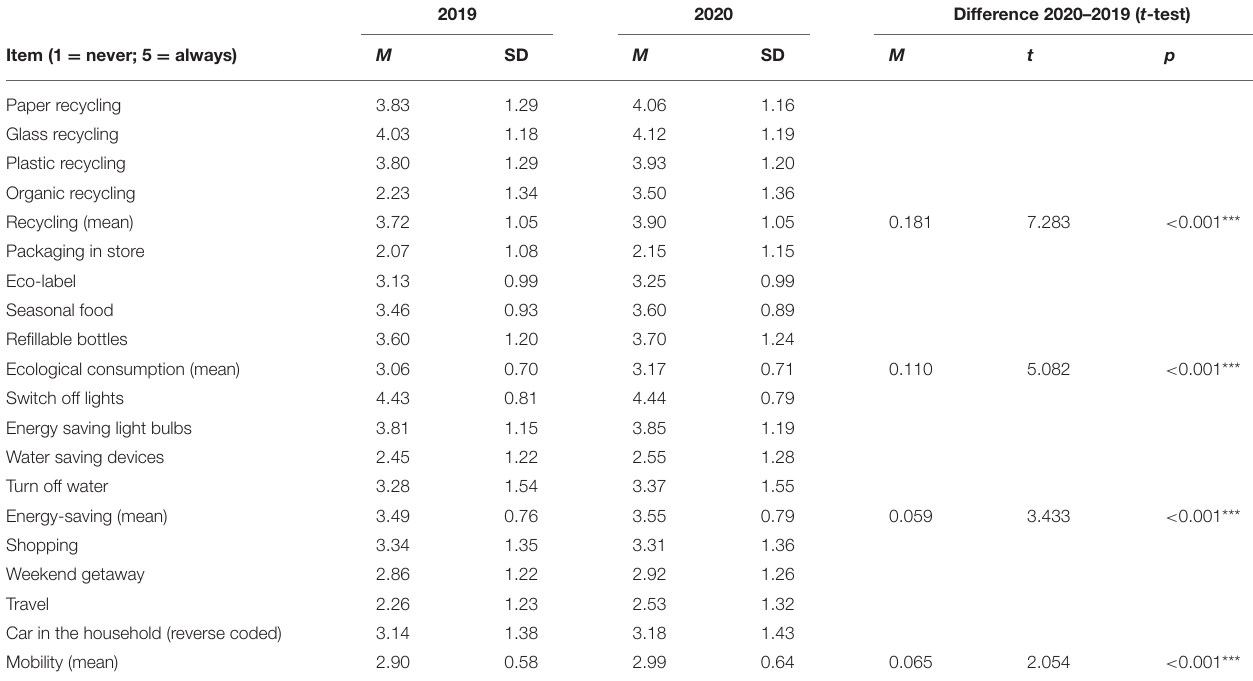
TABLE 3 | Environmentally sustainable behaviors in 2019 and 2020 ( n =